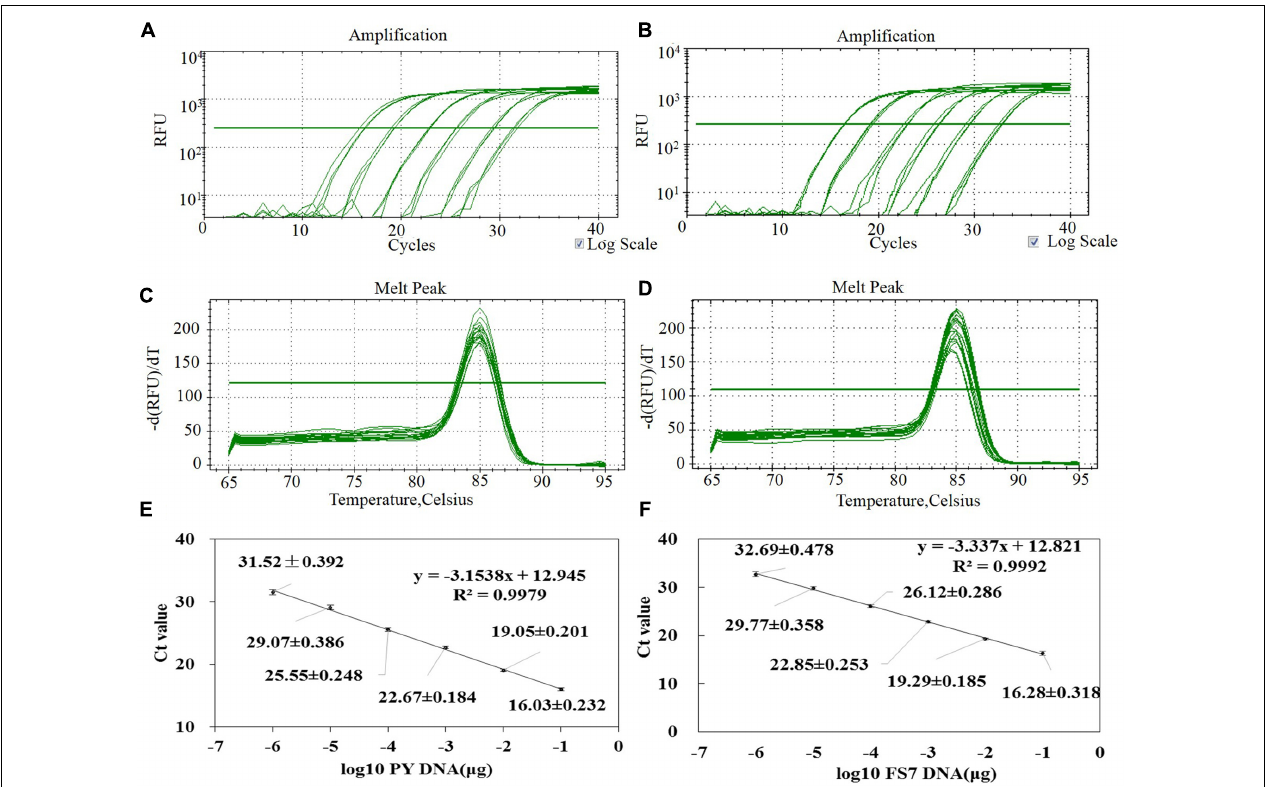
FIGURE 4 | Assessment of the method for the quantification of P. expansum genomic DNA through qPCR based on the primers pair patF-F/patF-R. (A,B) Amplification curves of a set of six 10-fold serial dilutions of genomic DNA from strains PY and FS7 of P. expansum showing the fluorescence signal plotted versus log of PCR cycle number (blank controls were also performed but fluorescence signal was observed). (C,D) Dissociation curve of the PCR product. (E,F) Standard curve generated by qPCR assay using 10-fold serial dilutions of pure genomic DNA from strains PY and FS7 of P. expansum ; Ct values were obtained for each dilution and plotted versus known quantities of genomic DNA used in the